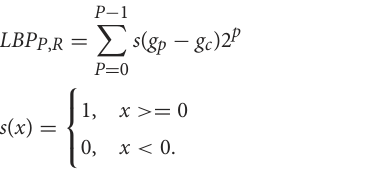
FIGURE5 Both the original image and segmented image transform by the Gabor